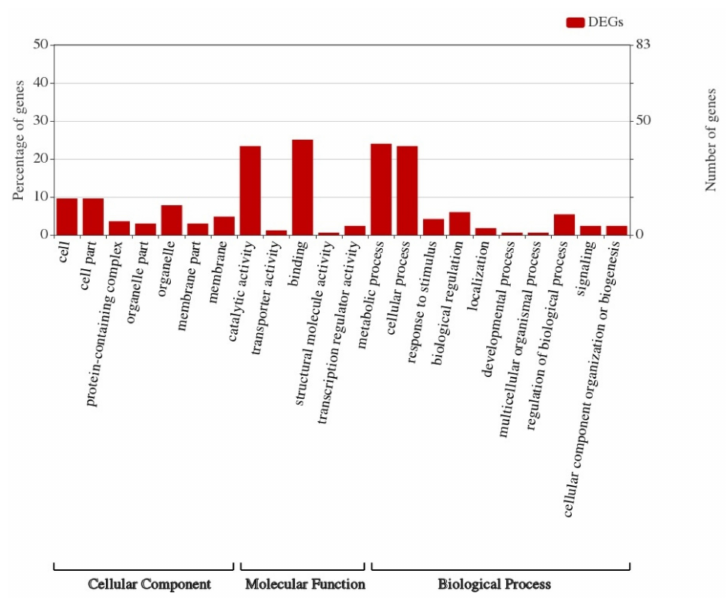
Figure 6. Gene Ontology analysis of transcriptome sequencing and import fragments.